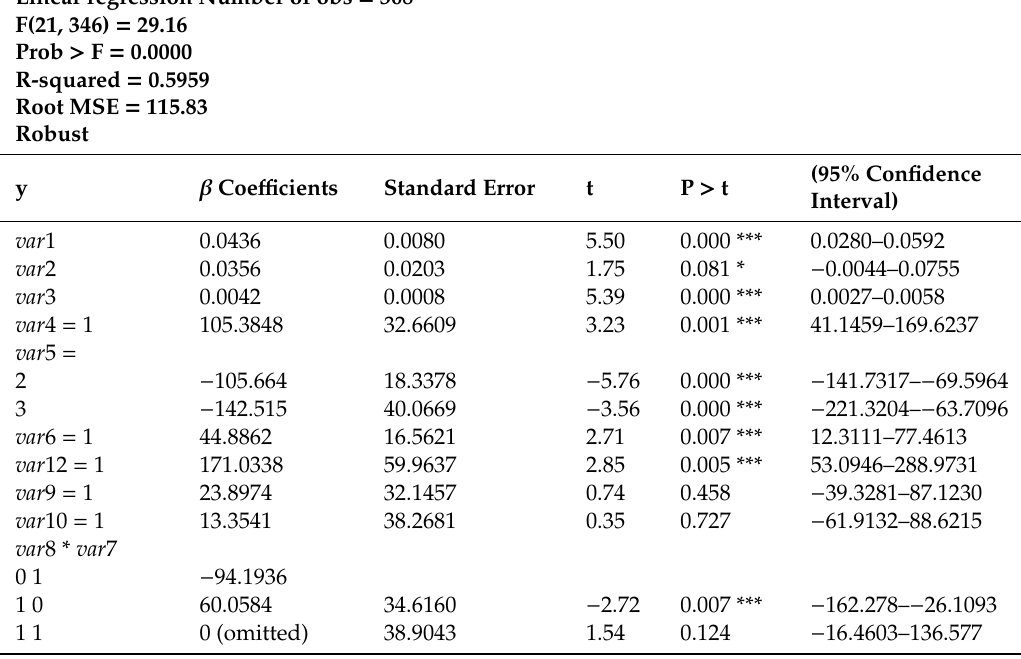
Table 2. The Regression Model based on Equation